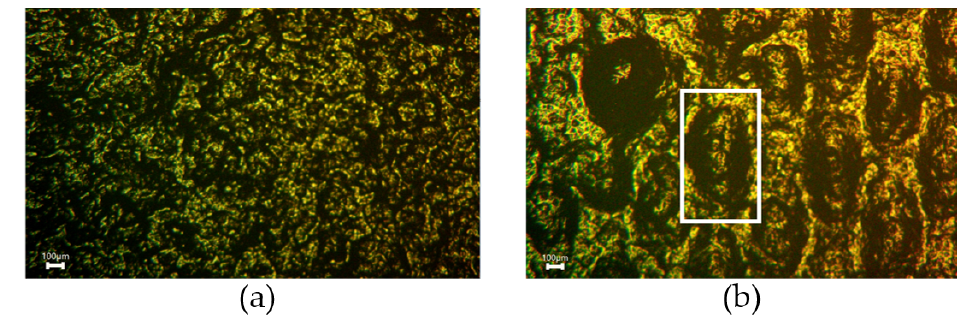
Figure 11. Microscopic investigations for different printed sensors: ( a ) homogeneous sample, ( b ) sam- ple having